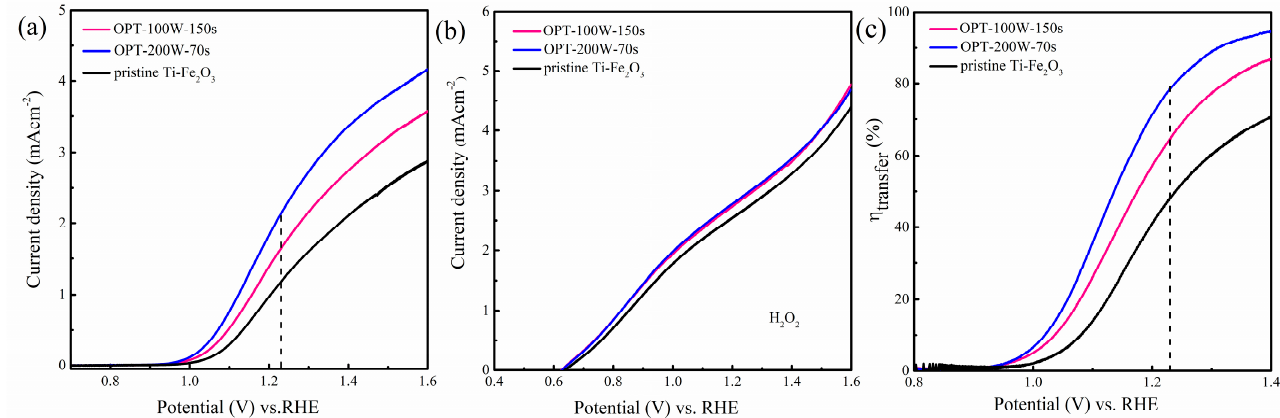
Figure 3. ( a ) The J-V curves of optimum OPT-Ti-Fe 2 O 3 and pristine Ti-Fe 2 O 3 photoanodes measured in the electrolyte of 1 M NaOH aqueous solution. ( b ) Linear sweep voltammetry (LSV) scans of OPT-100W-150s, OPT-200W-70s, and pristine Ti-Fe 2 O 3 photoanodes under irradiation in 1 M NaOH aqueous solution with 0.5 M H 2 O 2 from 0.4 V to 1.6 V vs. reversible hydrogen electrode (RHE) with a scan rate of 10 mV s − 1 . ( c ) Charge transfer efficiency of OPT-100W-150s, OPT-200W-70s, and pristine Ti-Fe 2 O 3 .